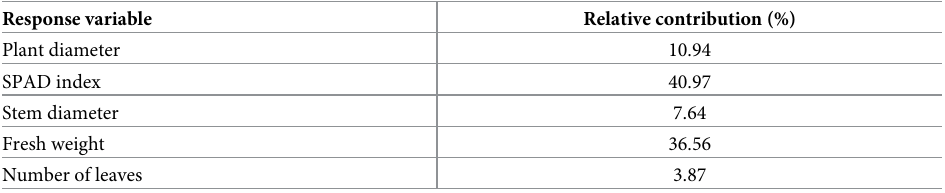
Table 2. Relative contribution of response variables for the dissimilarity between treatments calculated from Euclidean distance.